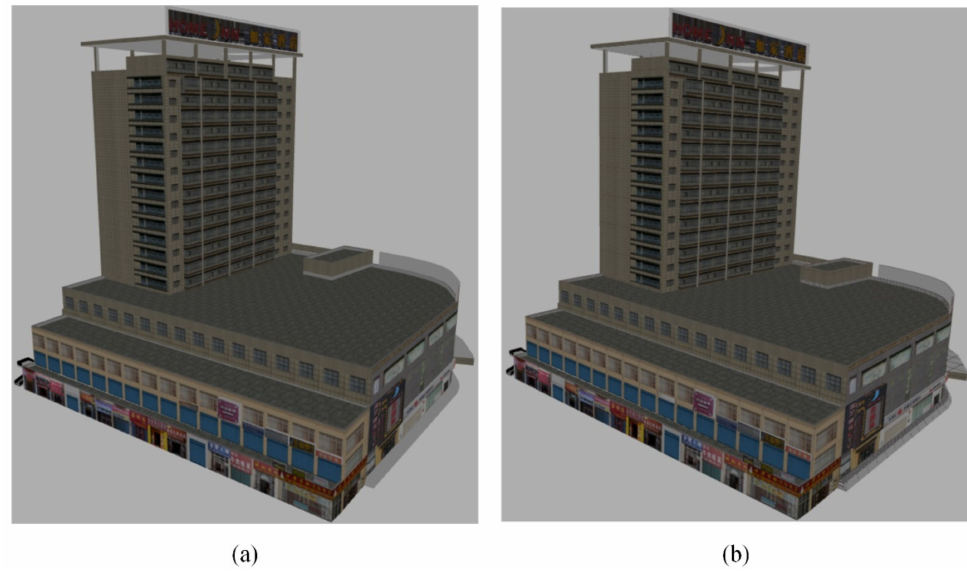
Figure 11. Textured model: ( a ) original model and ( b ) processed model.